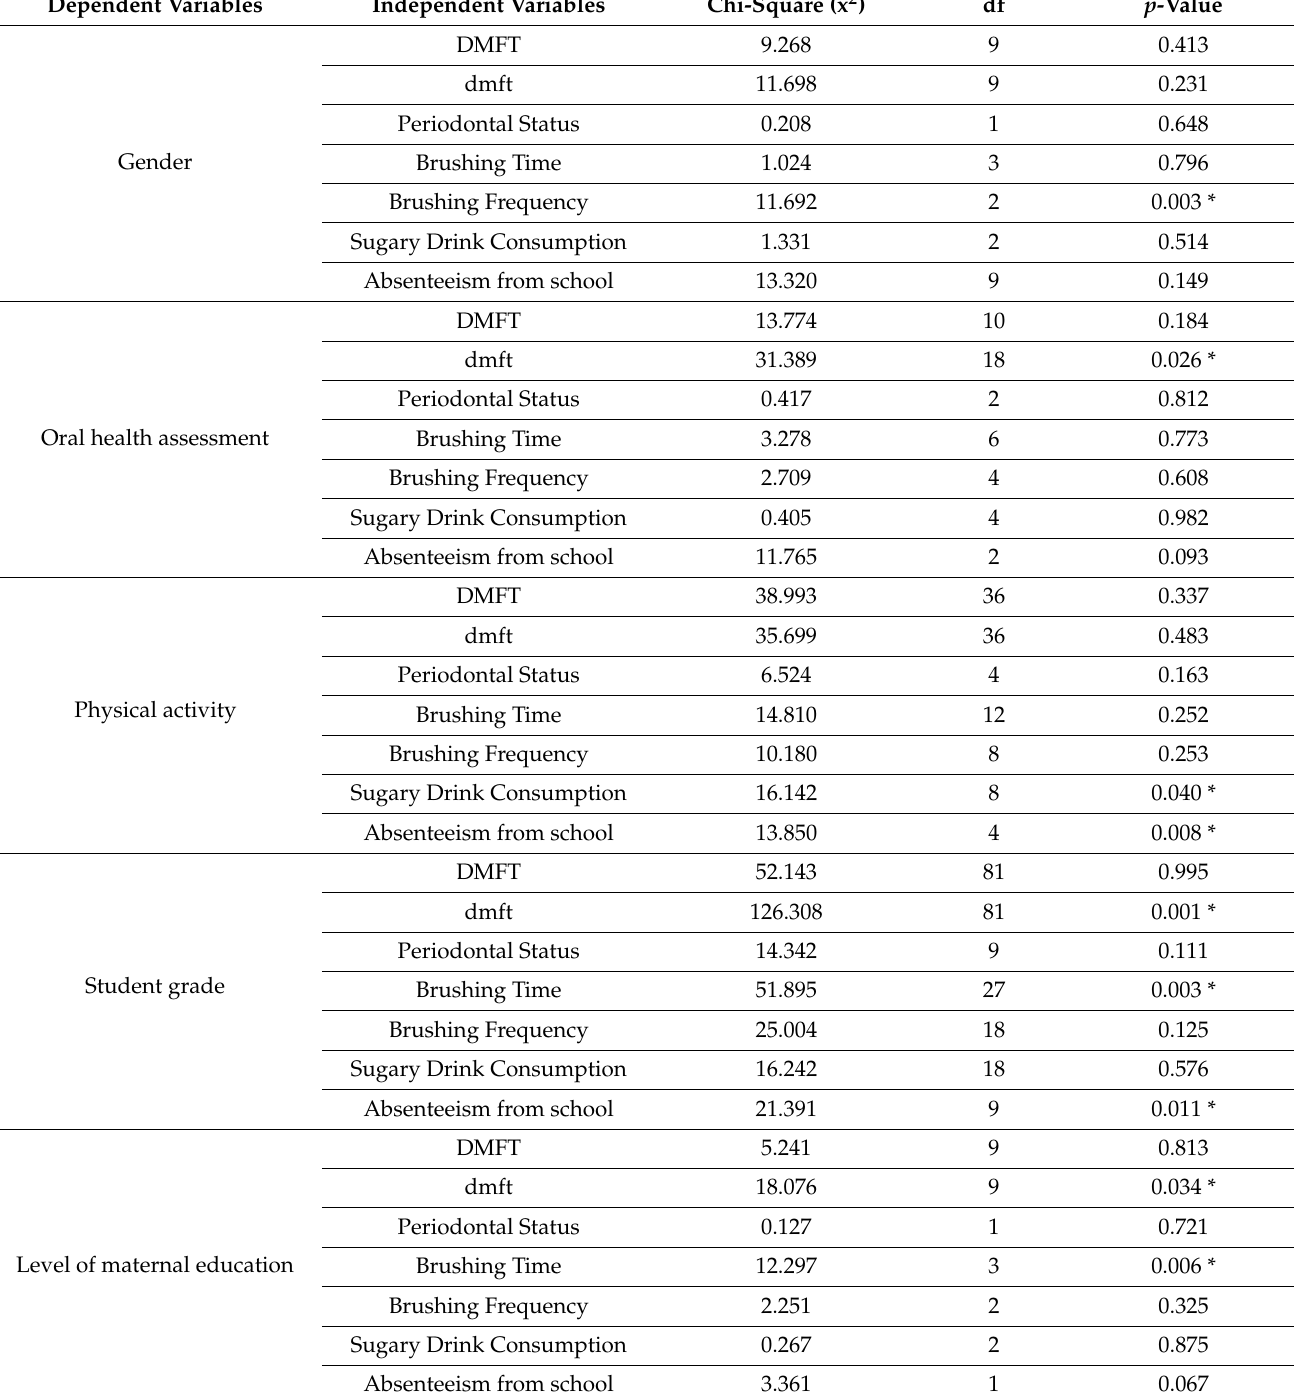
Table 3. Association of dependent and independent variables in the study (n =